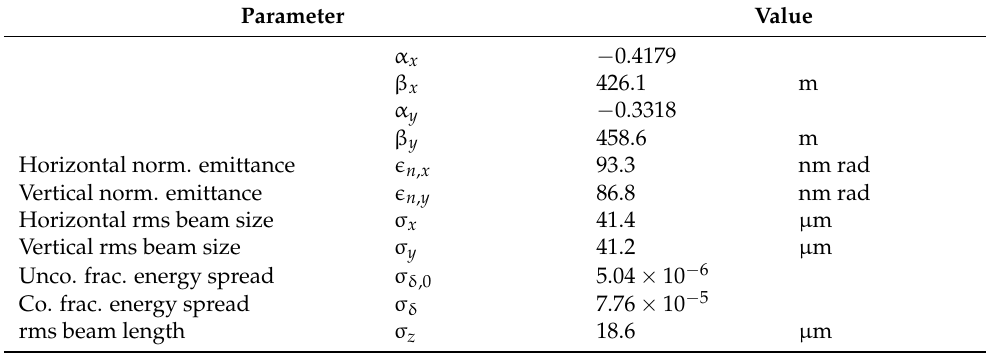
Table 5. Twiss parameters and other beam properties at L2 exit, as in lattice 1. Beam energy 12 GeV.